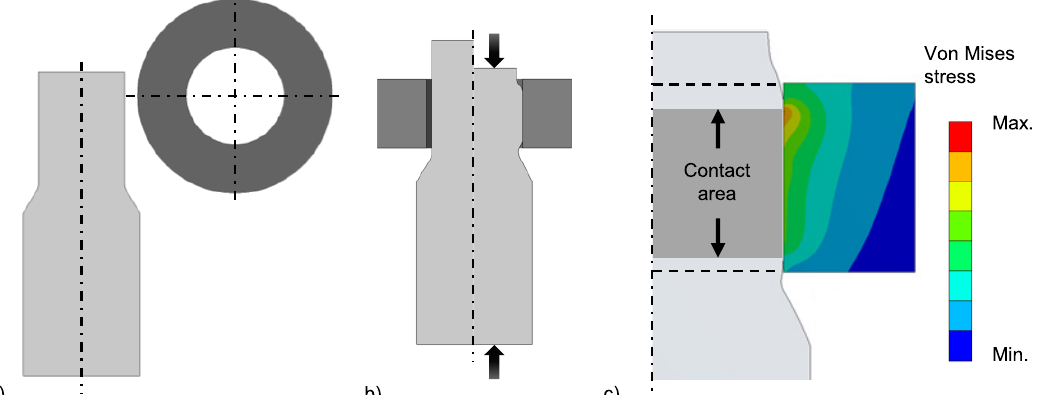
Fig. 1. (a) Shaft and hub; (b) assembly before and after joining by forming; (c) non-uniform von Mises stress distribution in the hub and incomplete form fi lling after joining by